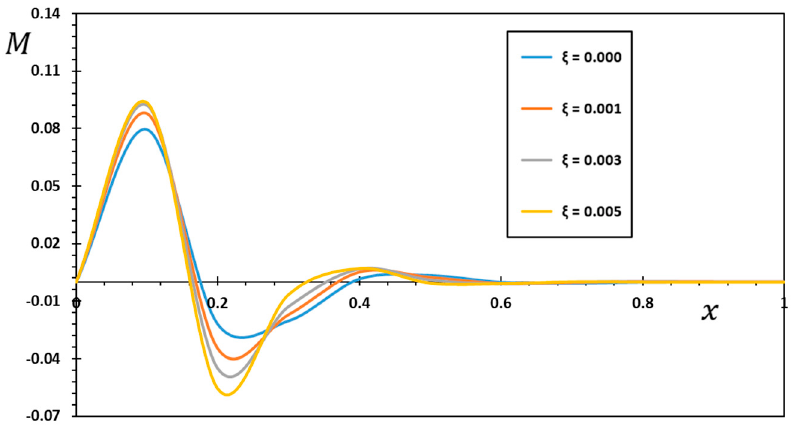
Figure 9. The bending moment, 𝑴 , under various nonlocal parameter 𝝃 values.